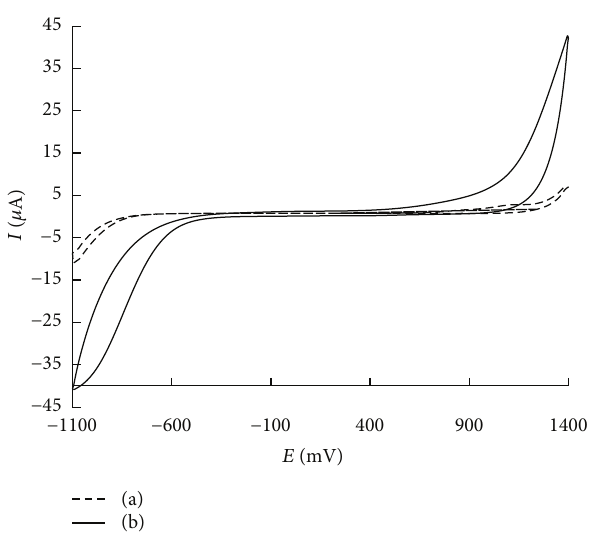
Figure 1: One cycle of CV run with a scan rate 100mV/s with a potential range from − 1100mV (initial) to +1400mV (final) with positive initial direction for three electrodes: (a) blank electrode; (b) Acetabularia -CPE. The supporting electrolyte is 0.1MKNO 3 .